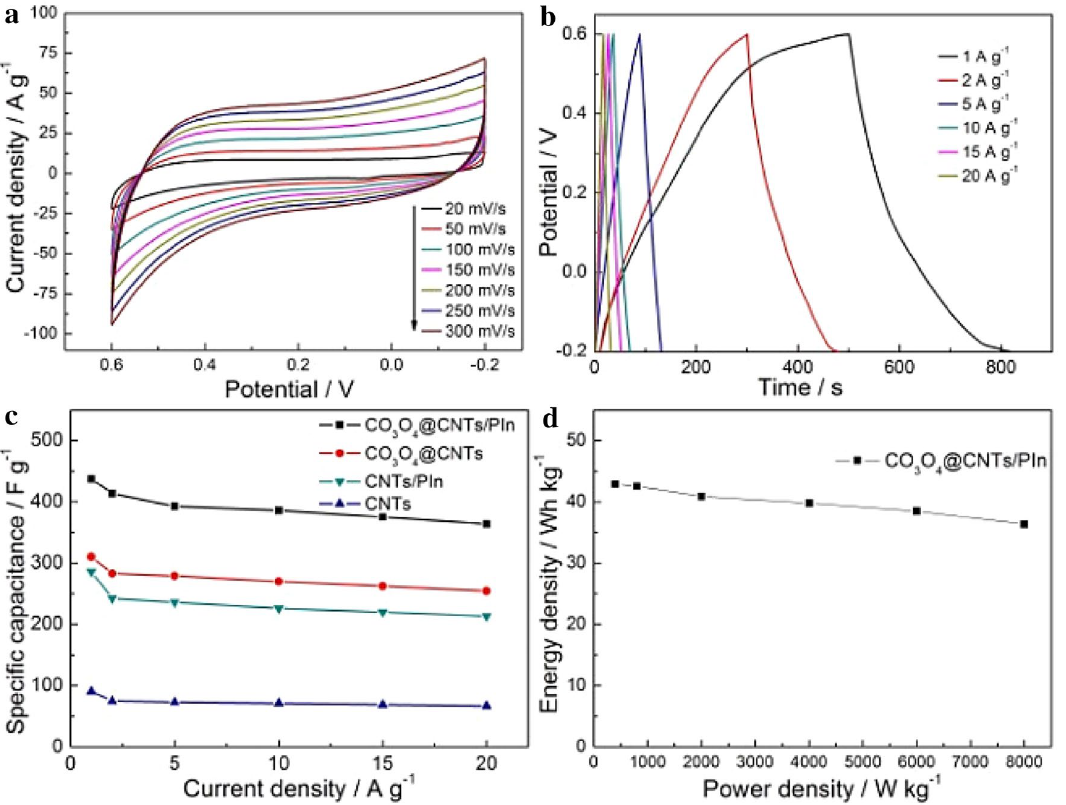
Fig. 5 CVs of PIN/CNT/Co 3 O 4: ( a ) galvanostatic CD of PIN/CNT/Co 3 O 4 ; ( b ) specific capacitances of CNT, PIN/CNTs, and CNT/Co 3 O 4 and PIN/CNT/Co 3 O 4 ; ( c ) Ragone plots of PIN/CNT/Co 3 O 4